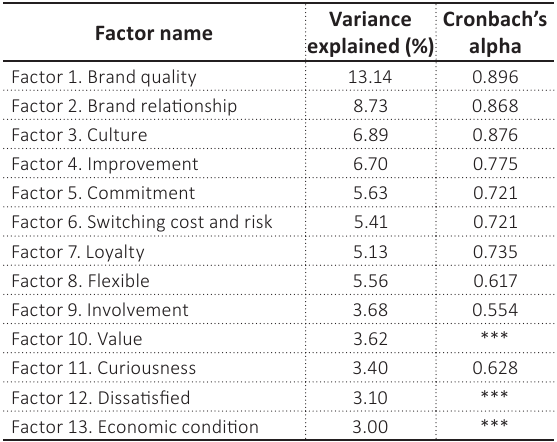
Table 6. Factors, variance explained and reliability